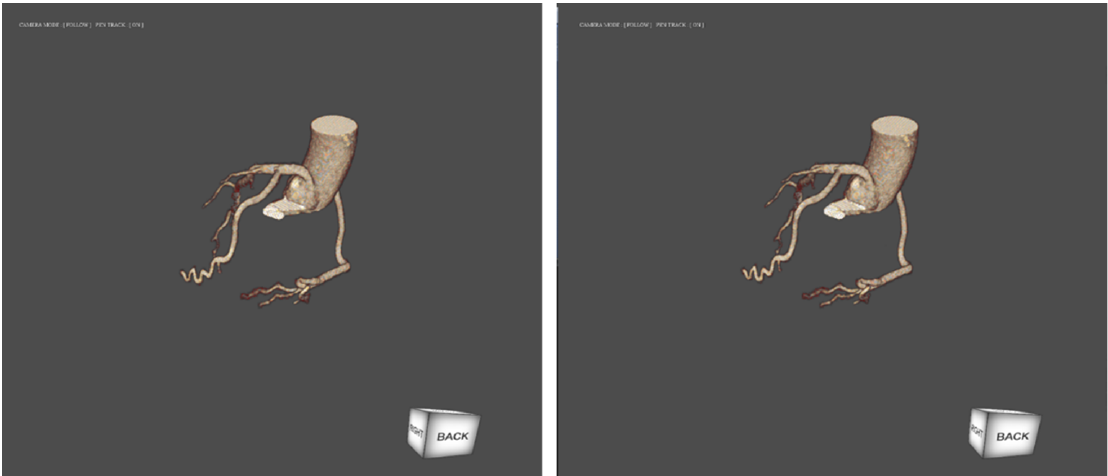
Figure 12. Stereo images from the volume rendered 3D coronary arteries from a coronary CT